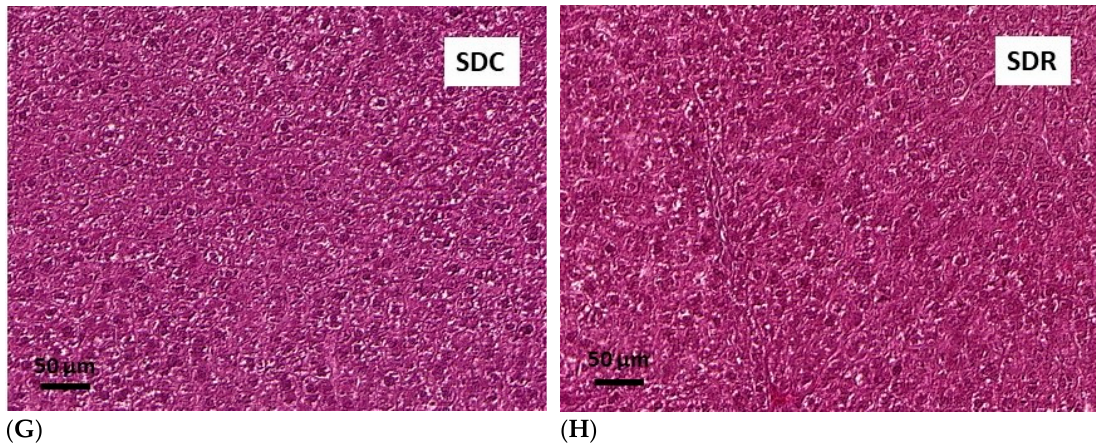
Figure 5. Effects of resveratrol on morphology of pancreatic islets and liver histology in GK and SD rats. GKC—Goto-Kakizaki control rats, GKR—Goto-Kakizaki resveratrol-treated rats, SDC—Sprague–Dawley control rats, SDR—Sprague–Dawley resveratrol-treated rats. The representative images of immunostaining for insulin of pancreatic islets counterstained with hematoxylin ( A–D ), the representative images of H&E staining of hepatic tissue ( E–H ). Magnifications shown by scale bars.